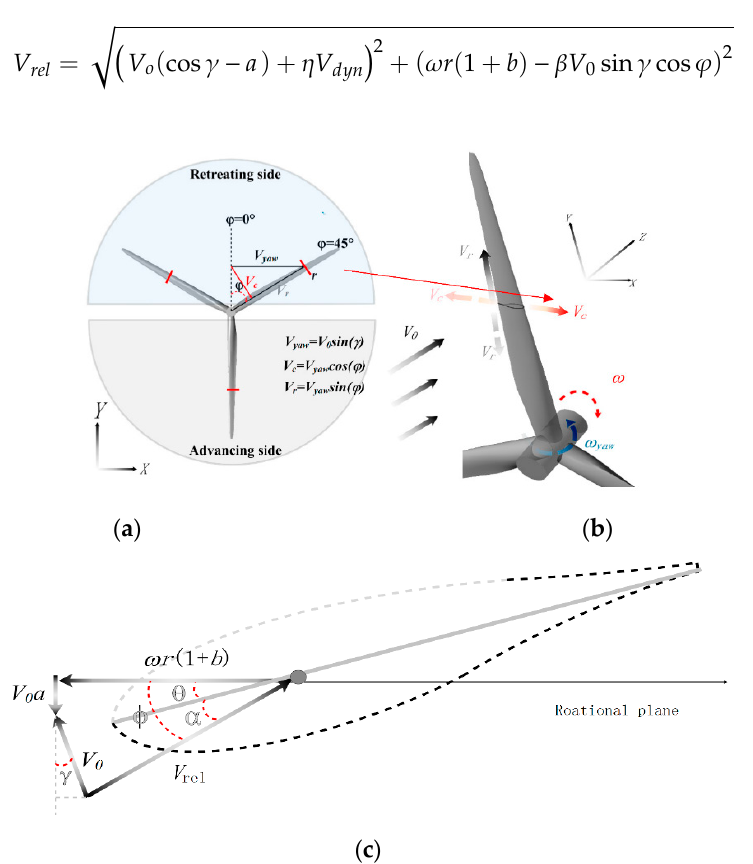
Figure 8. Section airfoil induced velocity V c under stable yaw: ( a ) magnitude of radial and chordwise velocity; ( b ) direction of radial and chordwise velocity; ( c ) velocity diagram of blade element.